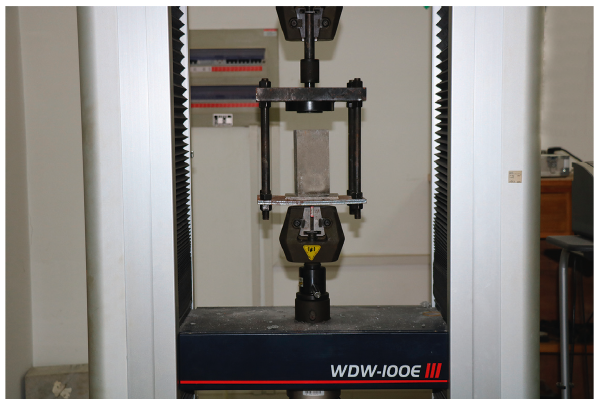
Figure 4: Connection diagram of